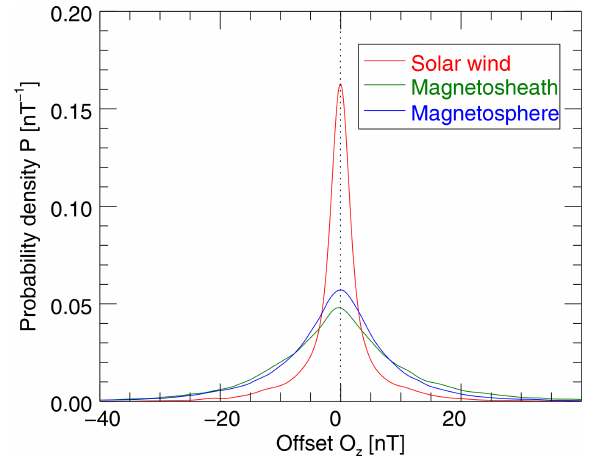
Figure 4. The relationship between 2- σ(O zf ) as a function of the number N of the offset estimates O z,n . 2- σ(O zf ) is the uncertainty of the determined best-estimate offset O zf with 95% confidence. The solid lines represent the linear least squares fits of the 2 σ con- fidence offsets above 0 .